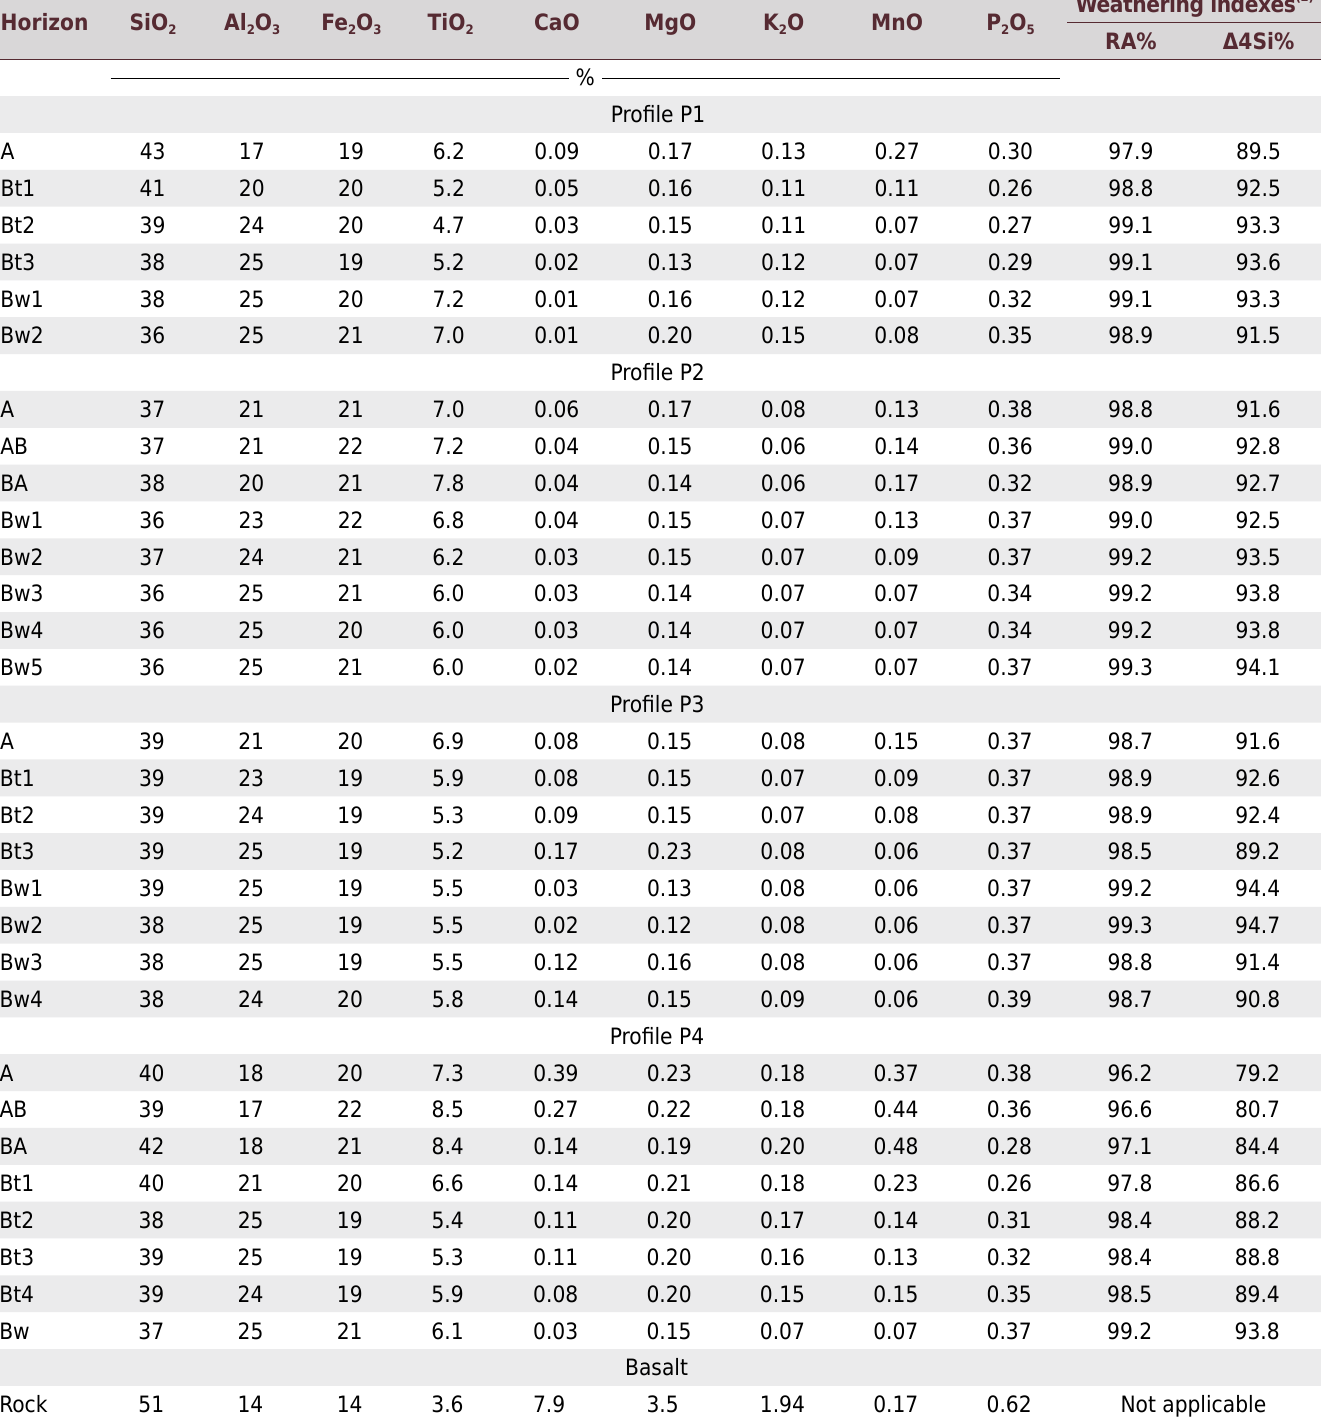
Table 5. Total chemical composition 1 and weathering indexes of the sampled soils and basalt rock in the Rio de Janeiro State, Southeastern Brazil Horizon SiO